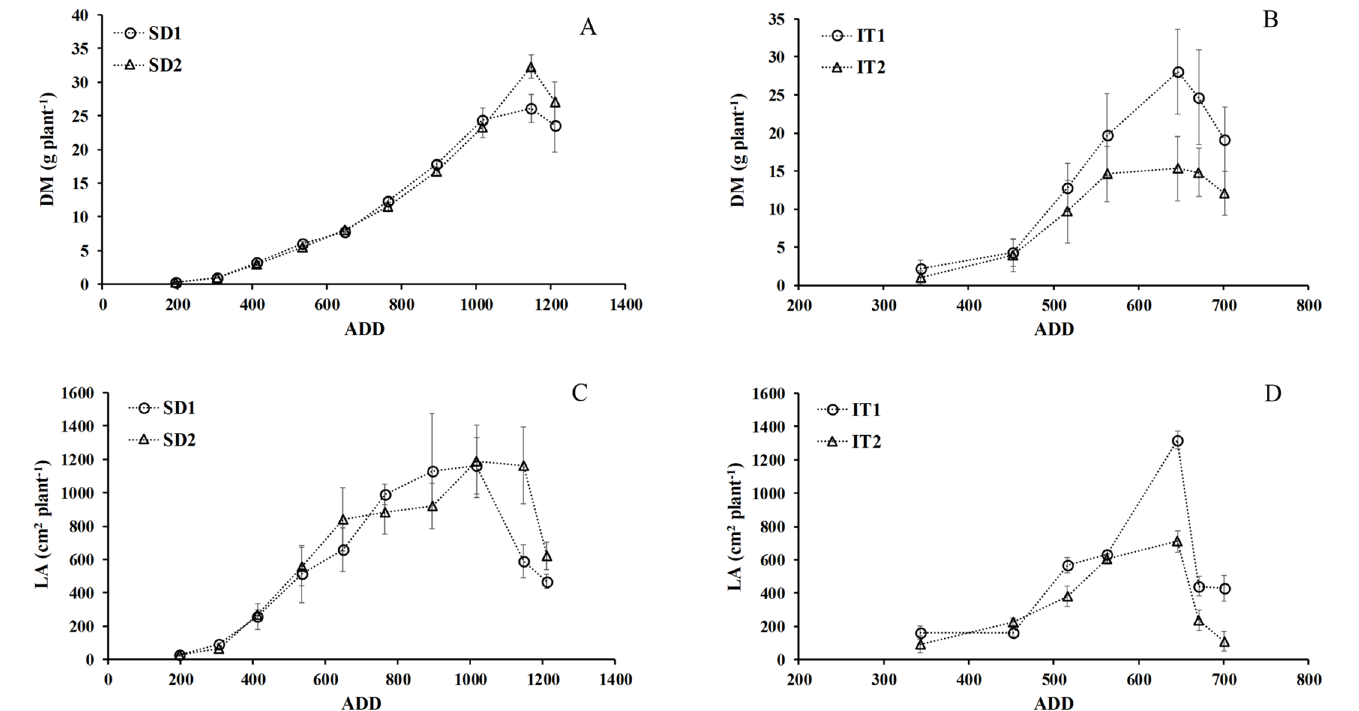
Fig 3. Mean dry matter production (DM) and leaf area development per plant (LA) from sowing to harvest as a function accumulated degree days (ADD). Sowing date (A, C) and water availability (B, D) in plants of chia established in Antumapu and Intihuasi, respectively.